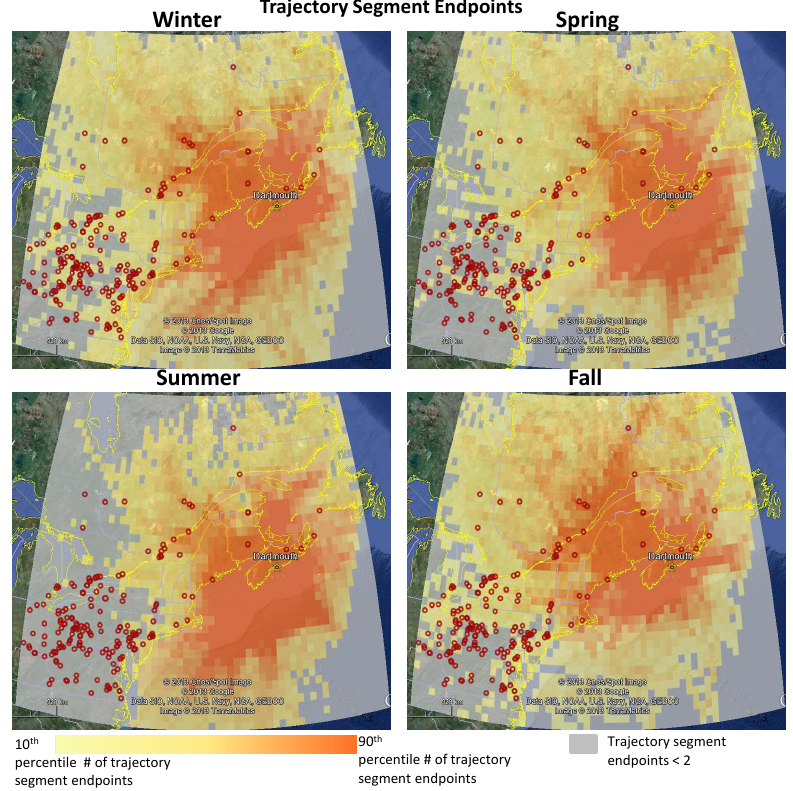
Fig. 7. Distances traveled by the 48h back trajectories in each season from the Dartmouth site. Grid cells shown in orange have a large number of trajectory segment endpoints (note: there is always a larger number of trajectory segment endpoints close to the receptor site); those shown in yellow have few trajectory segment endpoints; those shown in grey have < 2 trajectory segment endpoints. Red circles are the locations of known industrial Hg sources emitting > 5kg of Hgyr − 1 in 2010 and